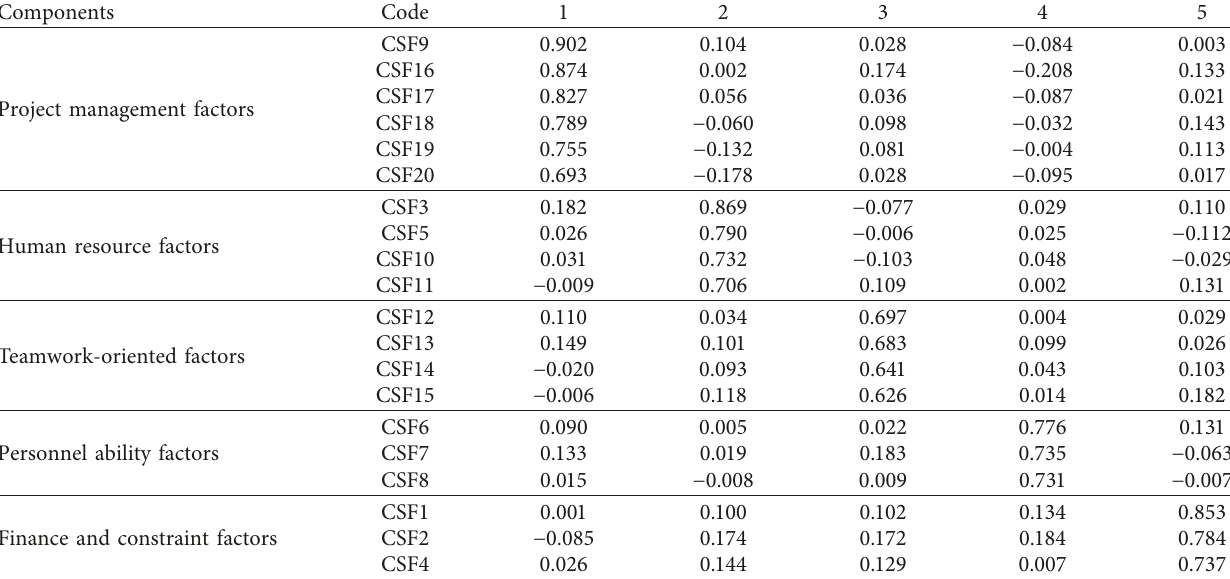
Table 4: Factor loadings of critical success